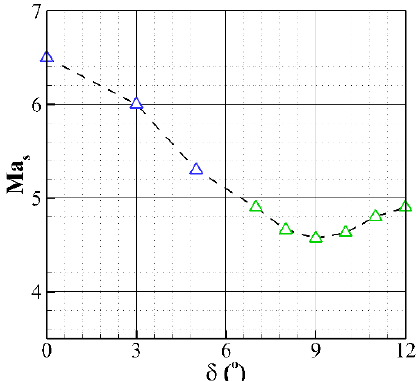
Figure 11. Starting Mach number distribution of the inlet with different cowl lip angles.